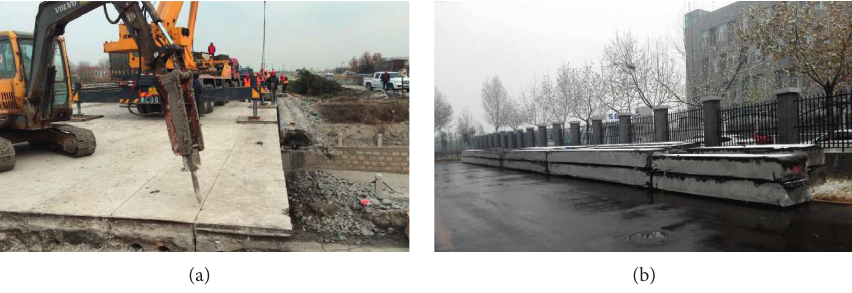
Figure 1: In situ construction: (a) demolition; (b) storage.